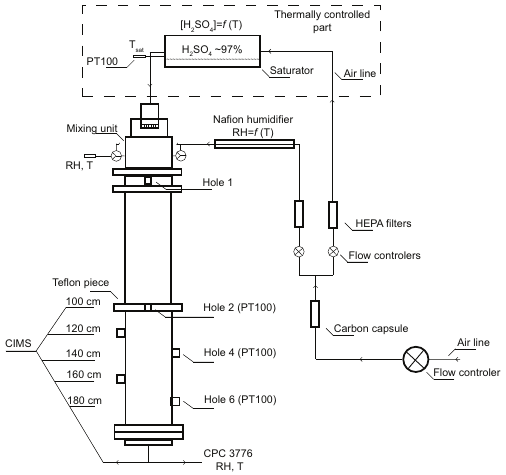
Figure 1. The schematic figure of the FMI flow